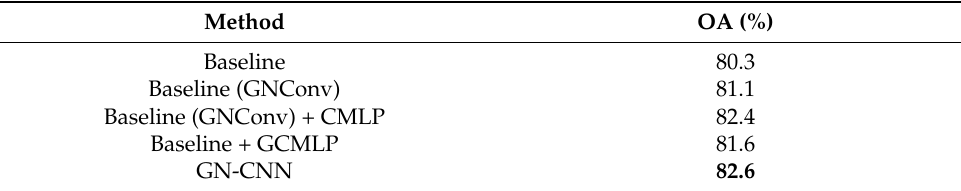
Table 5. Ablation study based on